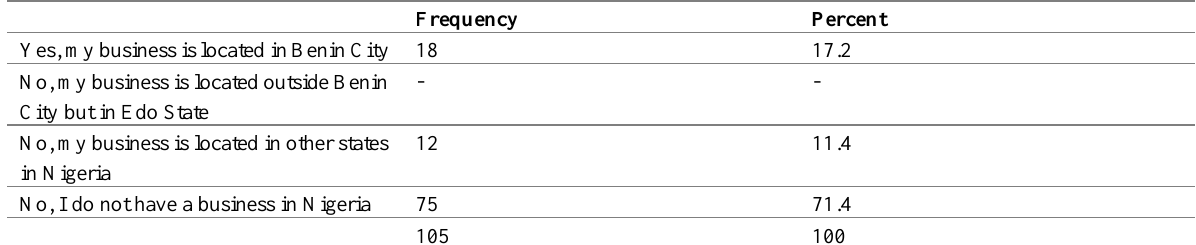
Table 2: Do you have a business in Benin City? Frequency